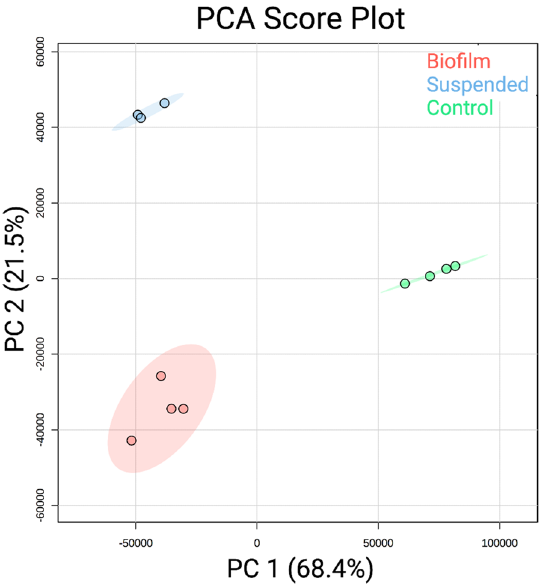
Figure 2. The two-dimensional score plot for principal component analysis (PCA) of the uninoculated BSF controls (green) (n = 4), suspended cultures (blue) (n = 3), and lawn biofilms (red) (n = 4). The PCA is based on the quantitation of identified metabolites showing clustering of sample cohorts with no overlap of the ellipses (ellipses represent 95% confidence intervals), displaying good separation between and repeatability within cohorts of